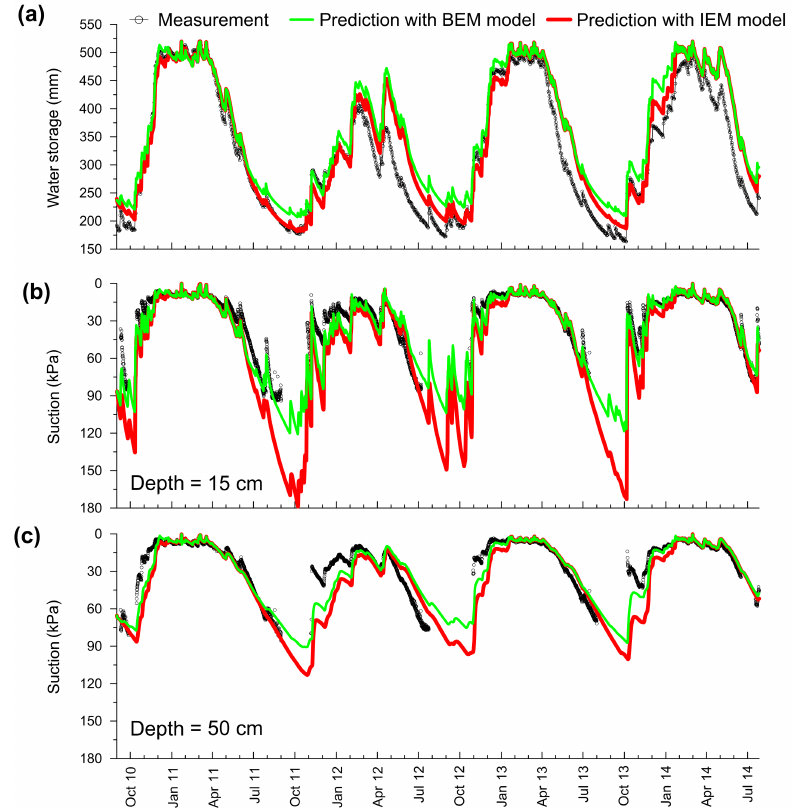
Figure 13. Comparison between IEM-predicted, BEM-predicted and observed hydrological behaviour: (a) comparisons in terms of water storage (WS) evolutions; (b) comparisons in terms of suction evolutions at depth of 15cm; (c) comparisons in terms of suction evolutions at depth of